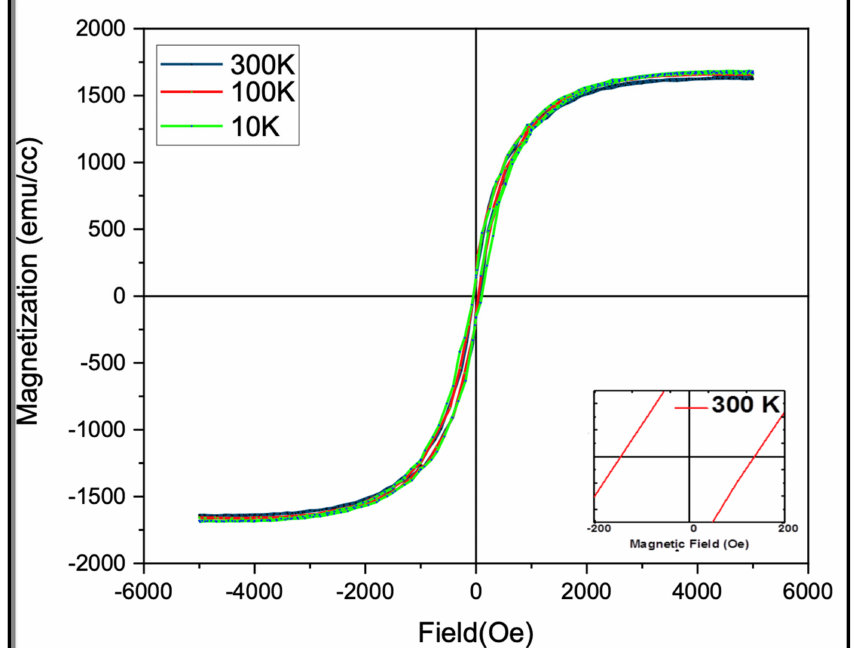
Figure 5. M-H curve showing room temperature ferromagnetism in Q-carbon composites with finite coercivity. The inset shows the coercivity of the intercepts with field at 300